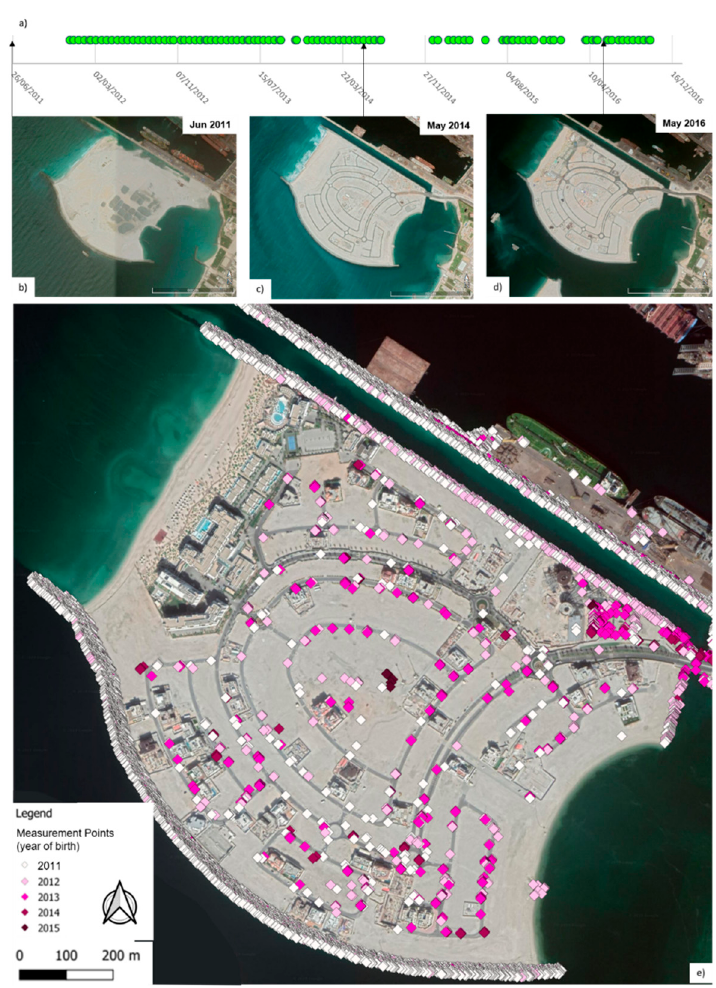
Figure 11 . Changes in the studied area over time. ( a ) Temporal distribution of satellite SAR images. ( b ) The studied area in June 2011(from Google Earth, Landsat image). ( c ) The studied area in May 2014 (from Google Earth, Landsat image). ( d ) The studied area in May 2016 (from Google Earth, Landsat image). ( e ) Temporary Measurement Point (MP). The colors identify the year of birth of the MPs. These results are derived using COSMO-SkyMed ® PRODUCTS, © ASI (Italian Space Agency)—provided under license of ASI.